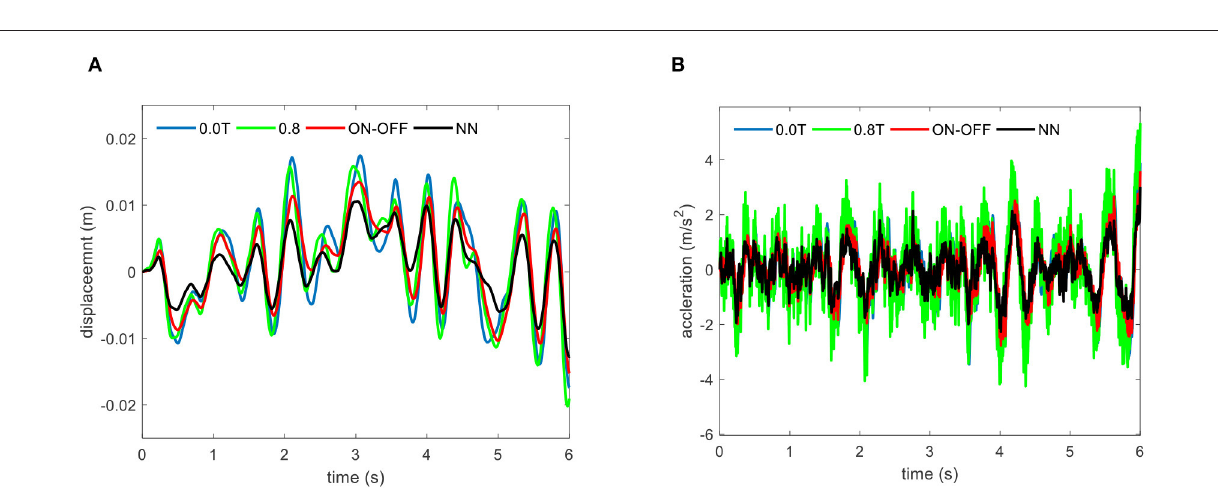
FIGURE 11 | The control input to the MRE-based isolator for bump shock; (A) ON-OFF controller, and (B) adaptive NN controller.